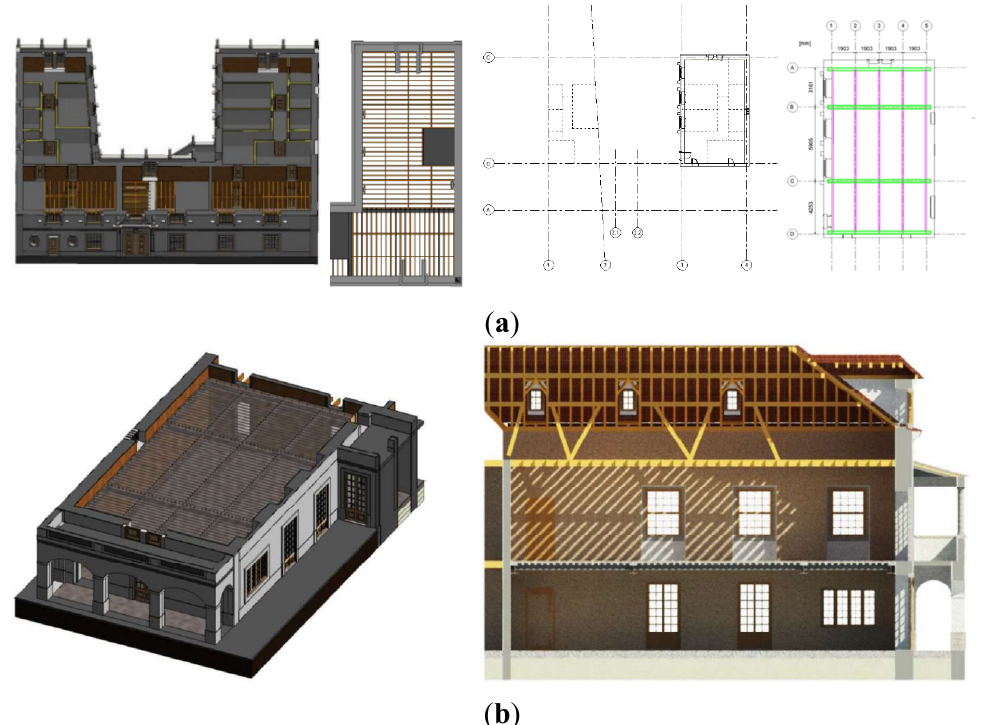
Figure 33. Modelling process of the composite slab.